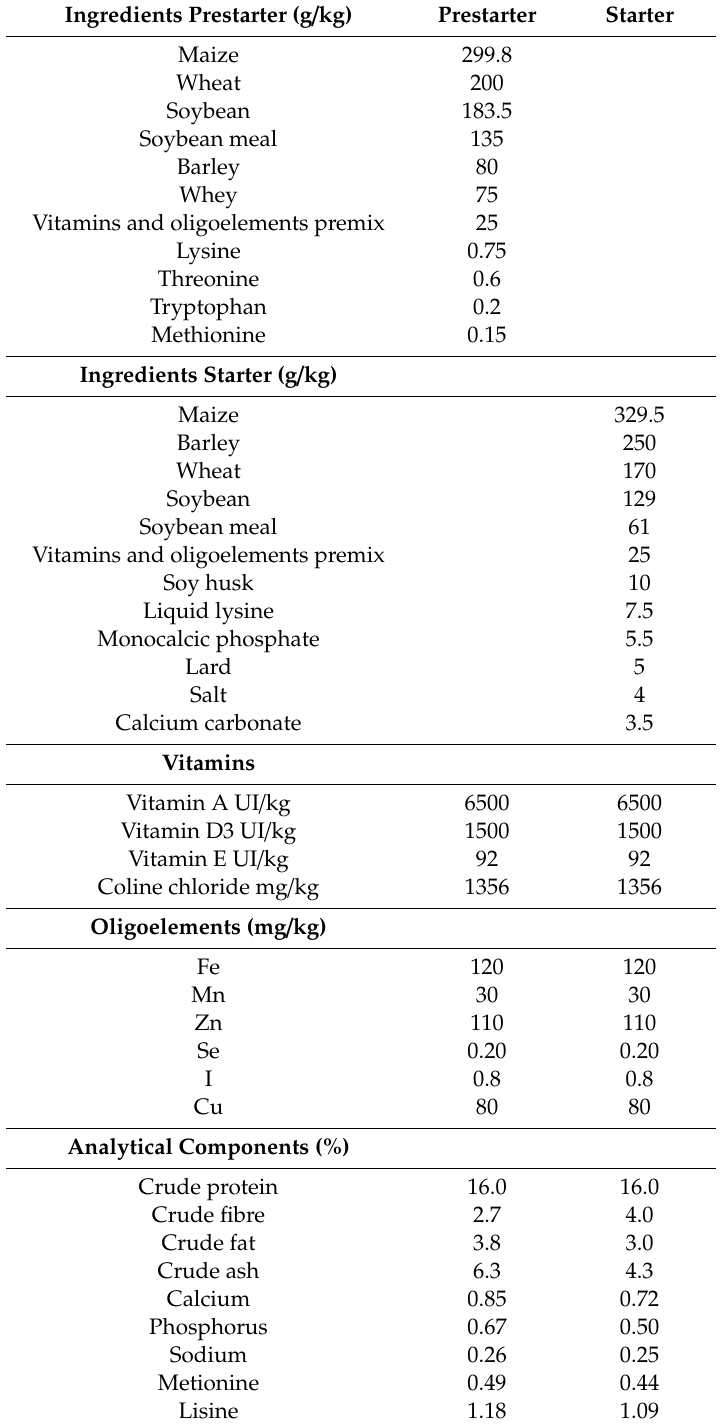
Table 3. Composition of the control